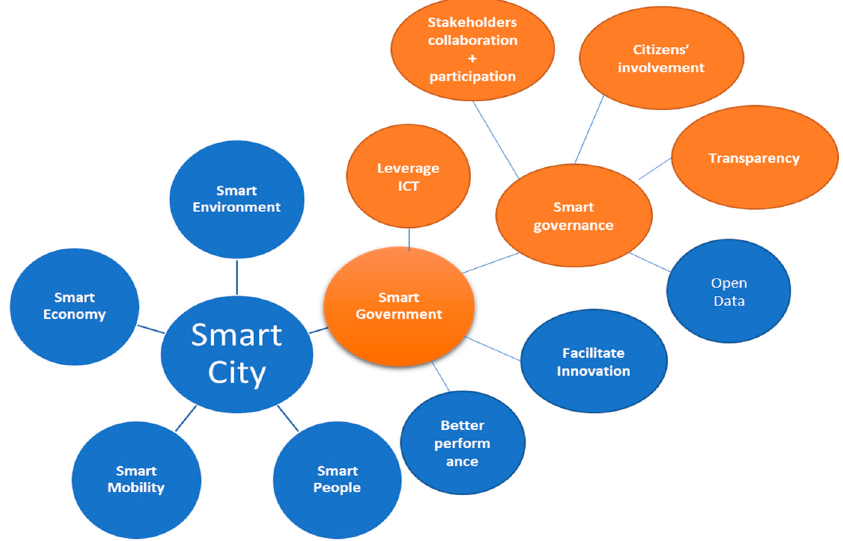
Figure 5. The relationship among Smart City, Smart Government and Smart Governance.